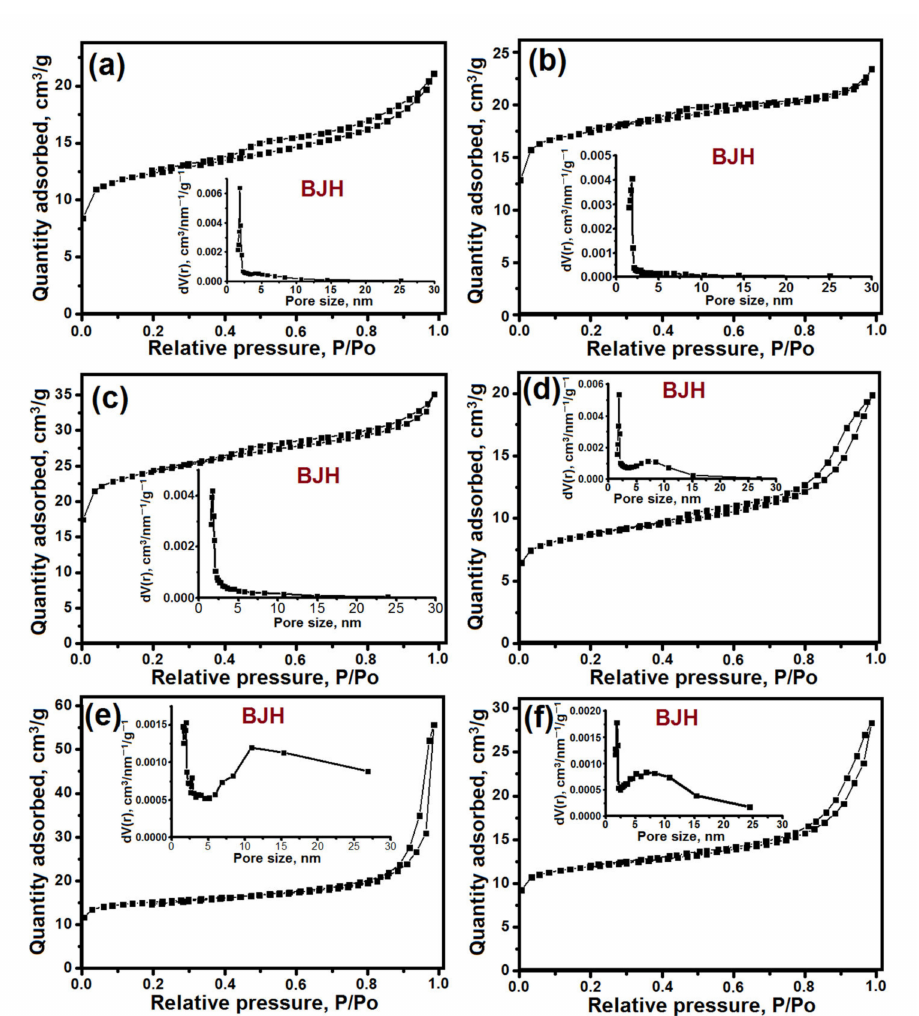
Figure 9. Nitrogen adsorption–desorption isotherms and pore size distribution (BJH) for the crys- tallization products based on silicoaluminophosphate gels: ( a ) Sample SAPO-11-PB-1.0; ( b ) Sample- SAPO-11-PB-1.5; ( c ) Sample-SAPO-11-iAl-1.0; ( d ) Sample-SAPO-11-iAl-1.5; ( e ) Sample-SAPO-11-PB- 1.0(90); ( f ) Sample-SAPO-11-PB-1.0(120). Table 3. Characteristics of the porous structure of crystalline silicoaluminophosphates. Sample S BET , m 2 /g S EX , m 2 /g V micro , cm 3 /g V meso , cm 3 /g SAPO-11-PB-1.0 196 110